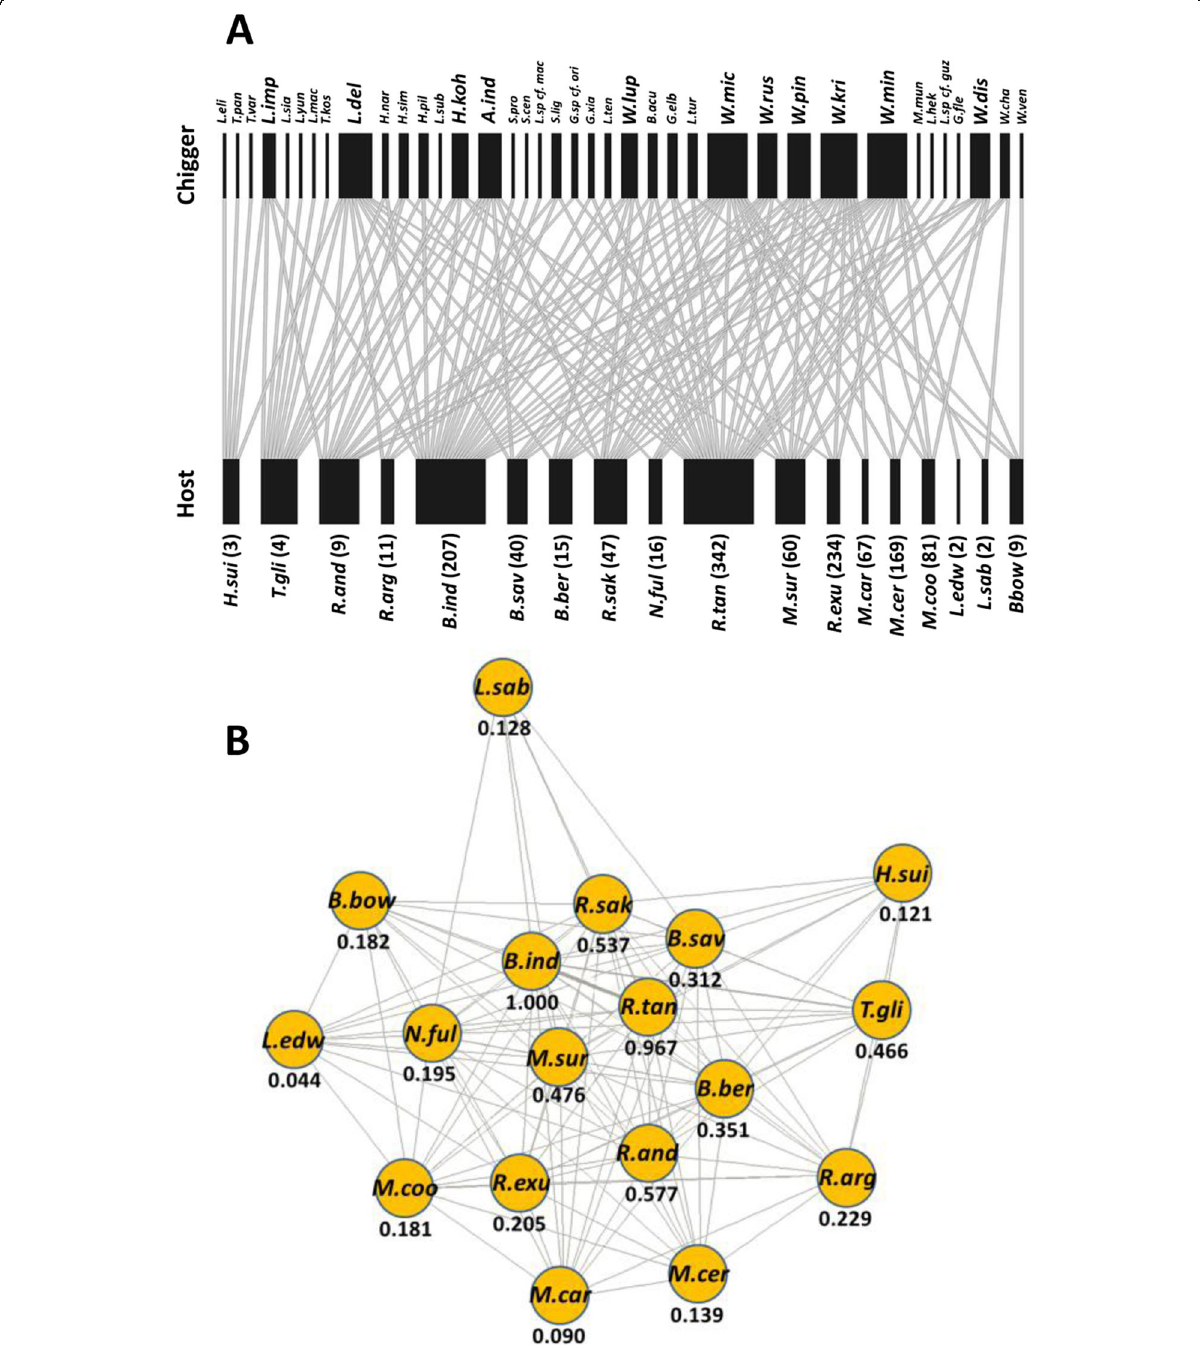
Fig. 3 Host-chigger associations in Thailand. a Bipartite graph based on presence-absence data. The number of individual hosts examined is shown in parentheses. Chigger species with broad host ranges are displayed in bold. b Unipartite network and Eigenvector centrality scores illustrating the pattern of chigger sharing among 18 small mammal